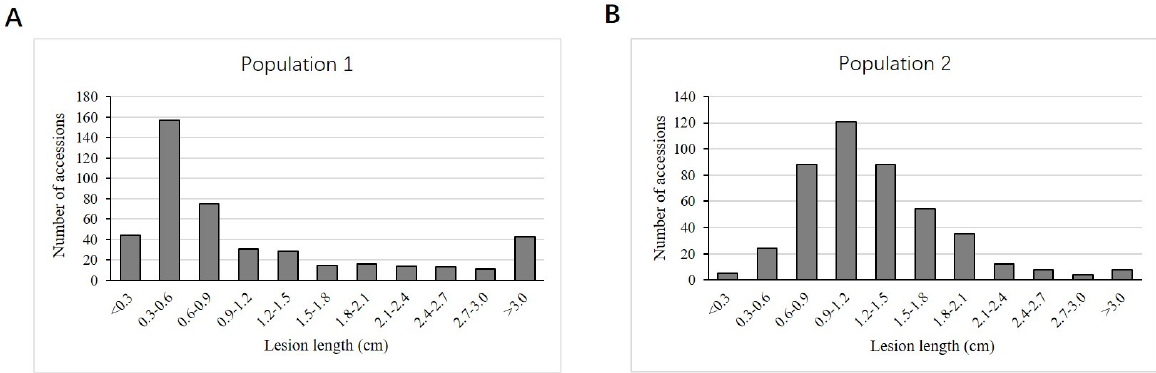
4 of 13 Figure 2. Pattern of LD decay in the whole panel of rice accessions used.